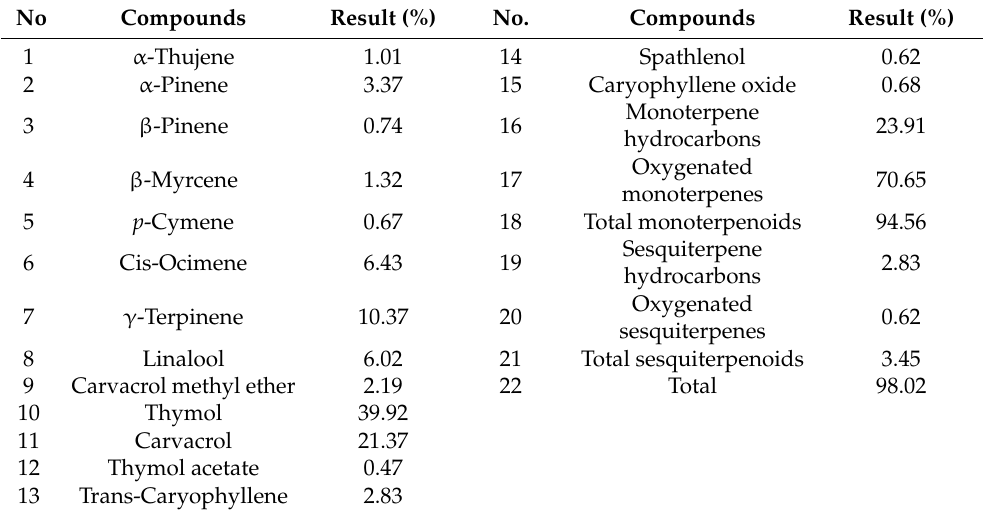
Table 2. Chemical composition of Z. multiflora EO extract by